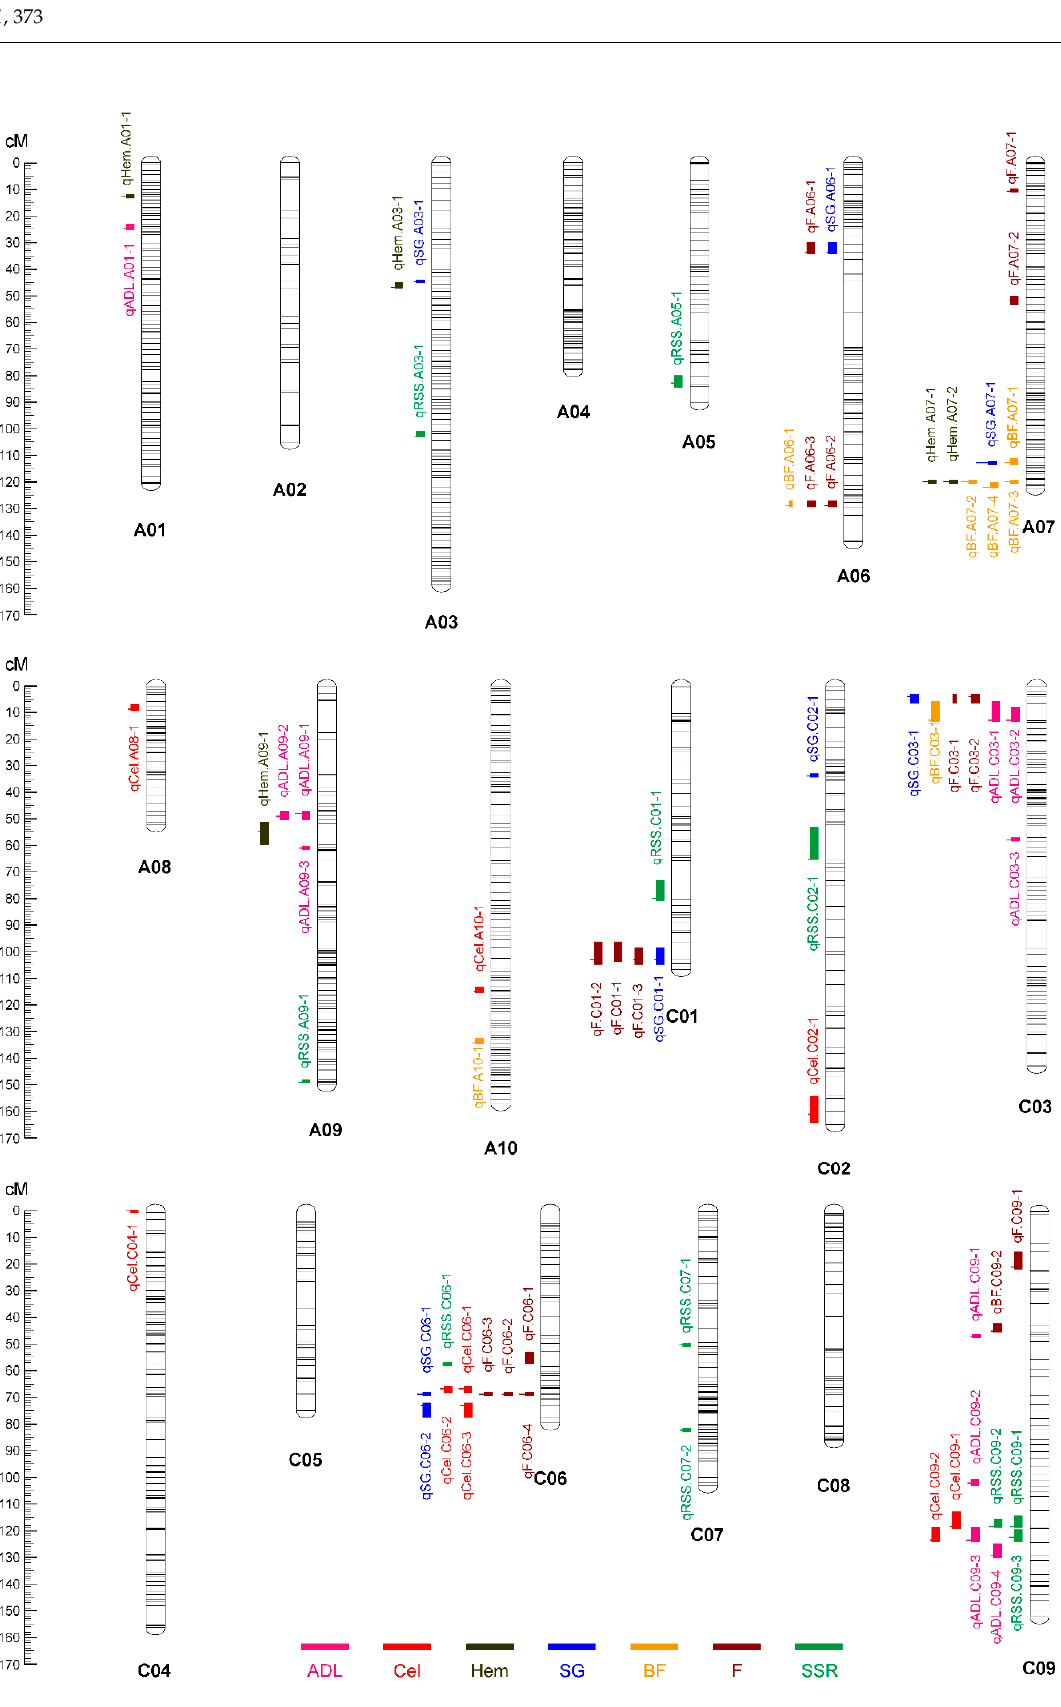
Figure 4. The identified QTL for ADL, Cel, Hem, SG, BF, F and SSR and their chromosome distribution. The length of the vertical bar in the “ ⊣ ” symbol indicates the confidence interval of the QTL, and the position of the horizontal bar indicates the peak position of the QTL.